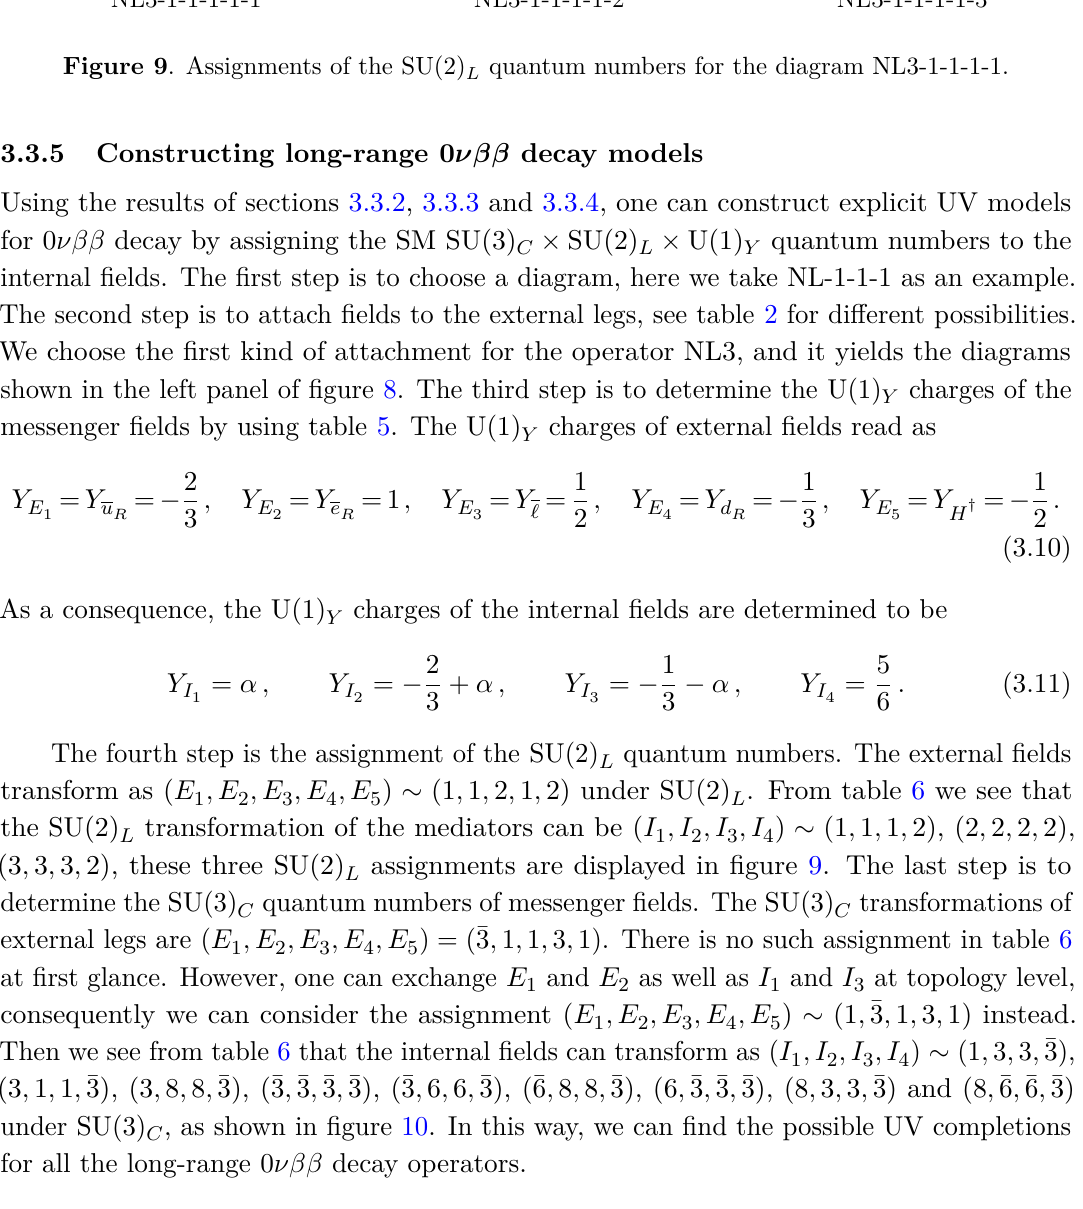
Figure 9 . Assignments of the SU(2)